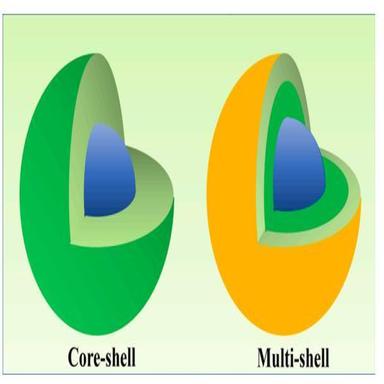
Schematic illustration of core–shell and multi-shell microencapsulated phase change materials.